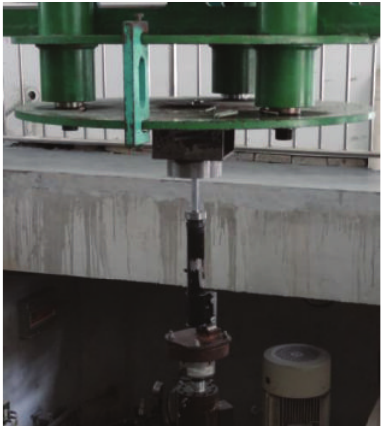
Figure 6: Components of the adjustable shock absorber and experimental setup.